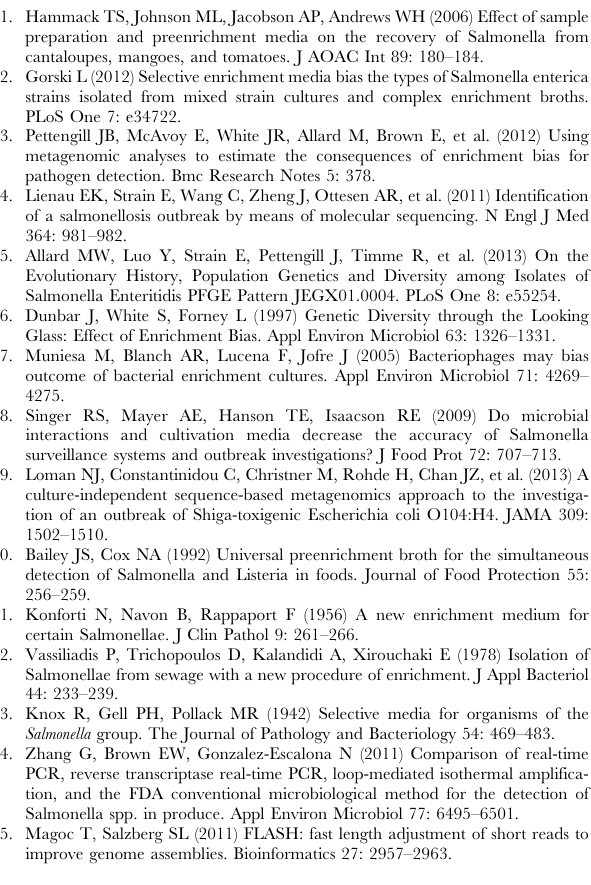
Figure S1 Results from the PCoA based on taxonomic assignments using a subsampled dataset ( , 25% of observed data) for both Flashed and Meta-Velvetg. Patterns were consistent across multiple levels and serve to illustrate that our observed pattern is not an artifact of insufficient sampling depth.